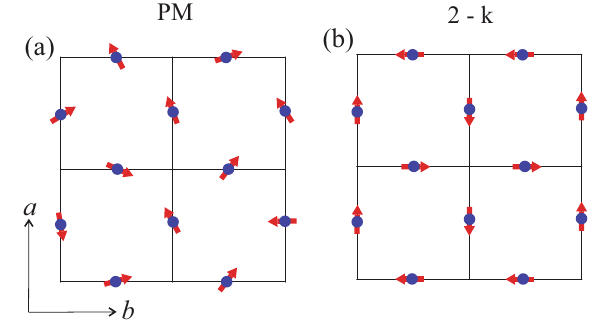
Fig. 2 Schematic illustrations of magnetic phases. For spins (red arrows) located at Fe atom positions (blue circles), the arrangements are given for a the paramagnetic (PM) high-temperature phase. The low-temperature antiferromagnetic phase ( b ) is the non-collinear 2- k